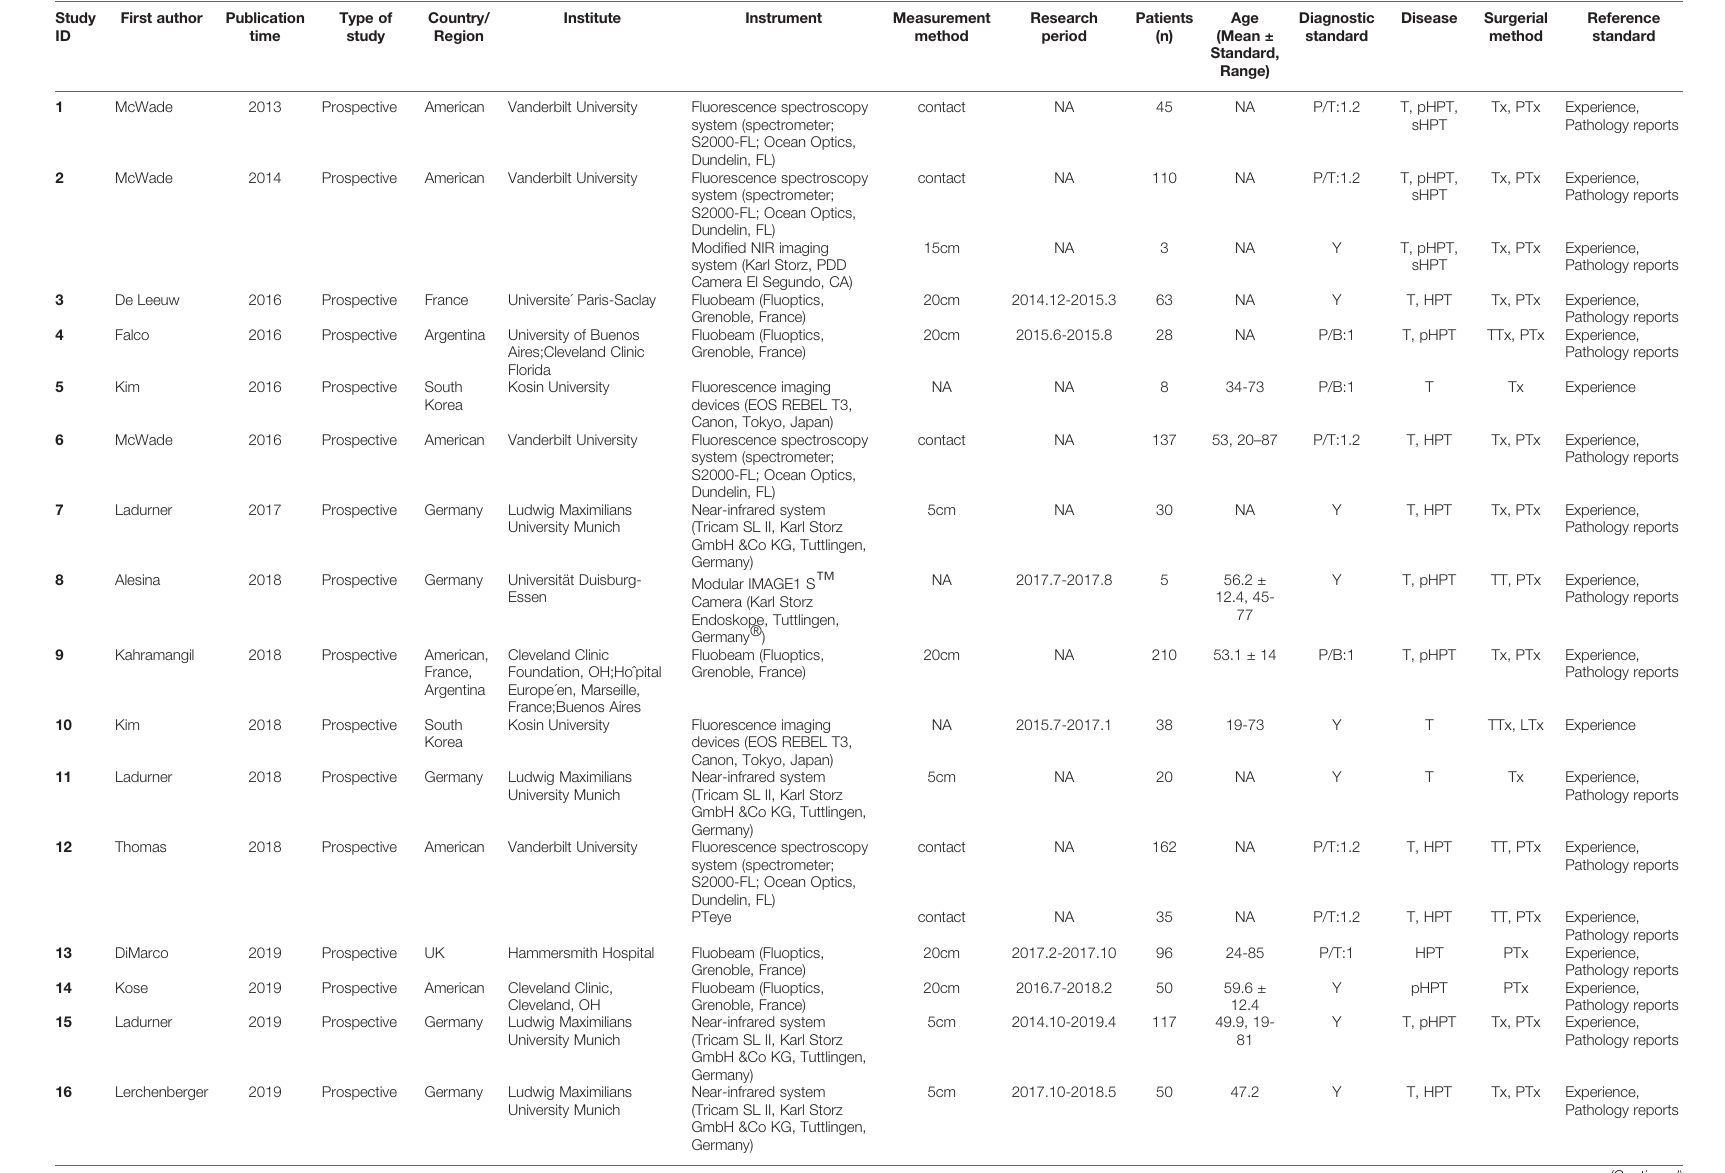
TABLE 1 | The characteristics of the included